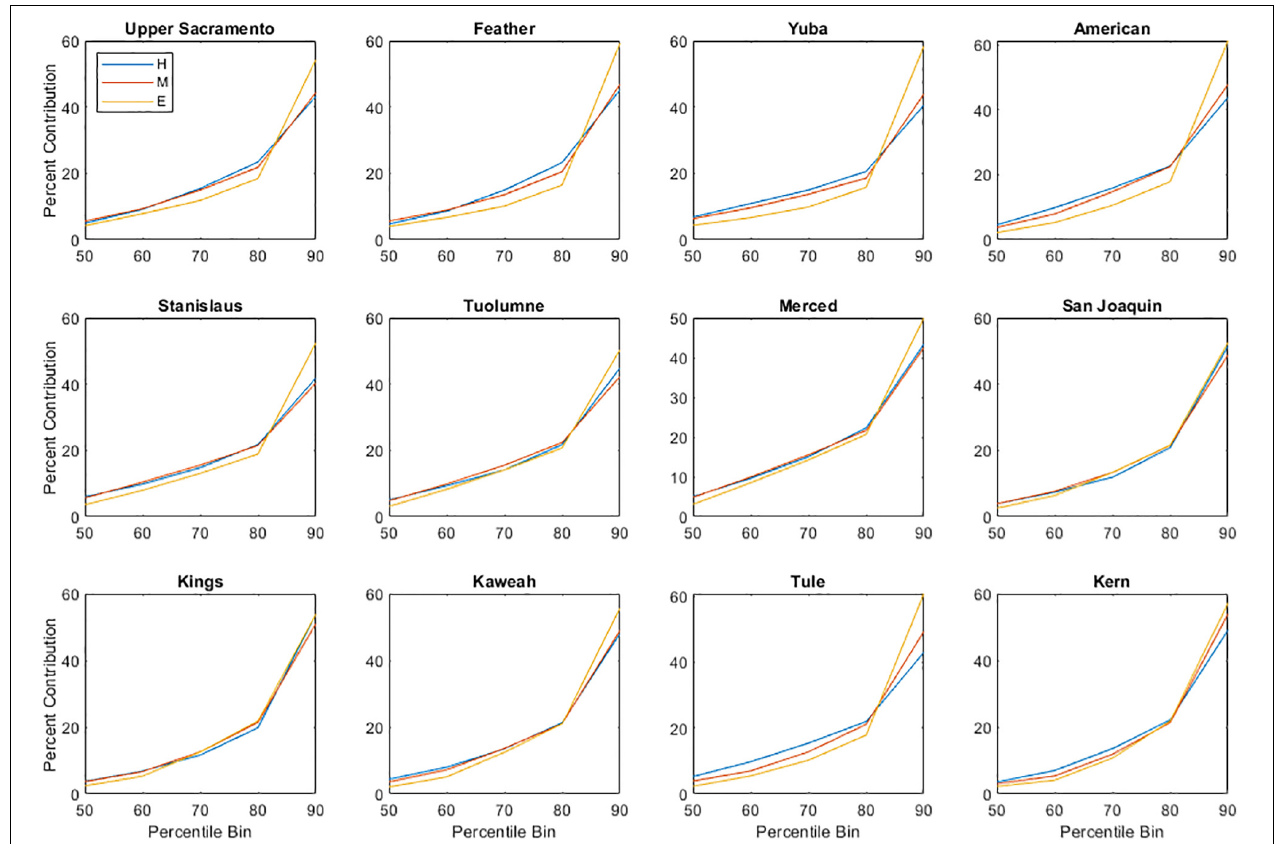
FIGURE 12 | Percent contribution of runoff within each percentile bin to total runoff, accumulated across each decade, for each Sierra Nevada basin. Percentile bins < 50th are not shown due to their small contribution to total runoff. Basins are sorted from north (Upper Sacramento) to south